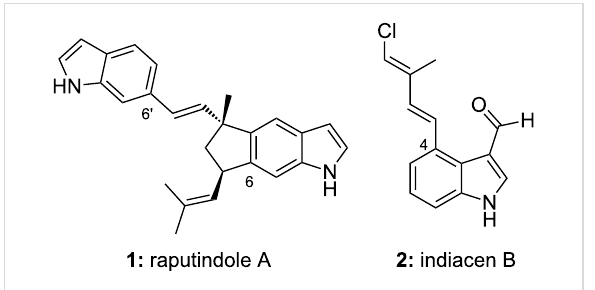
Figure 1: Prenylated indole alkaloids raputindole A from the ruta- ceous tree Raputia simulans and indiacen B from the myxobacterium Sandaracinus amylolyticus .